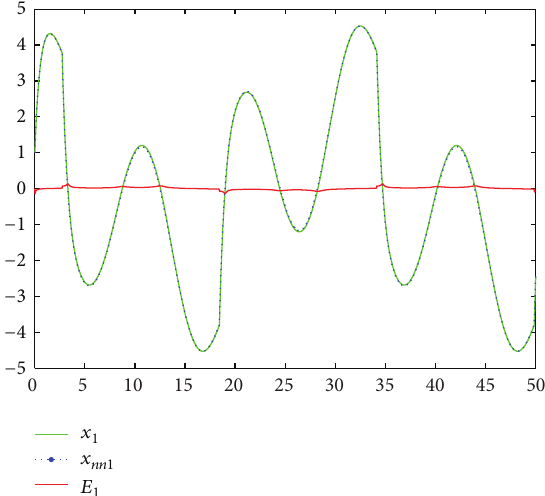
Figure 5: Identification result for system state 𝑥 1 .